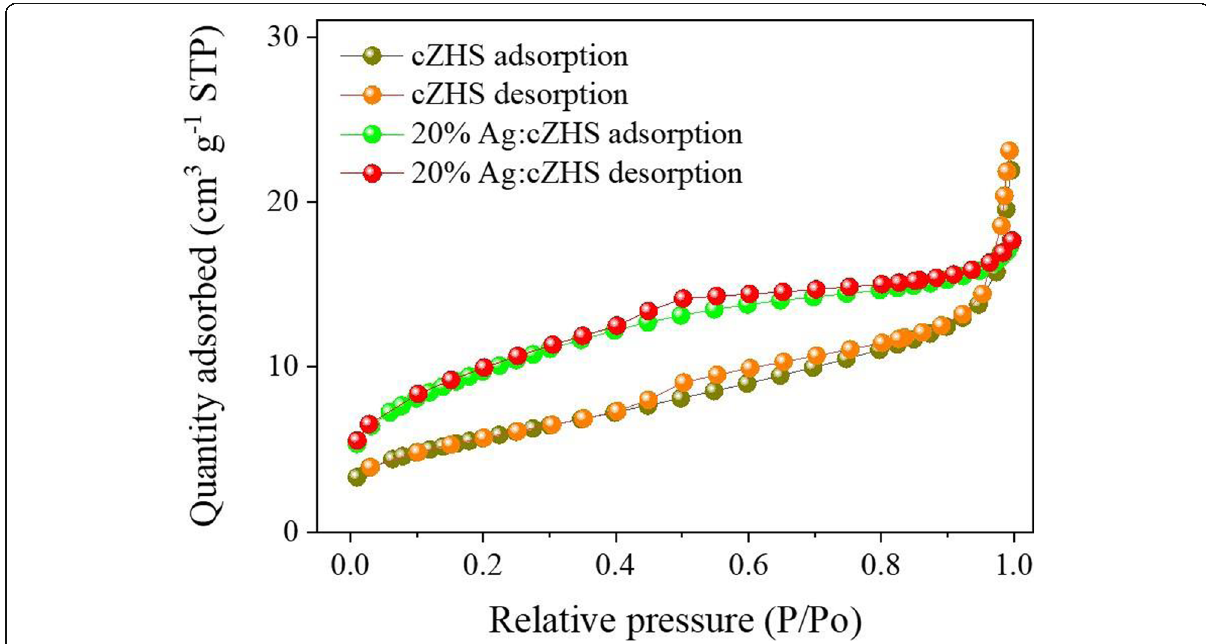
Fig. 6 N 2 adsorption-desorption isotherms of cZHS and 20%